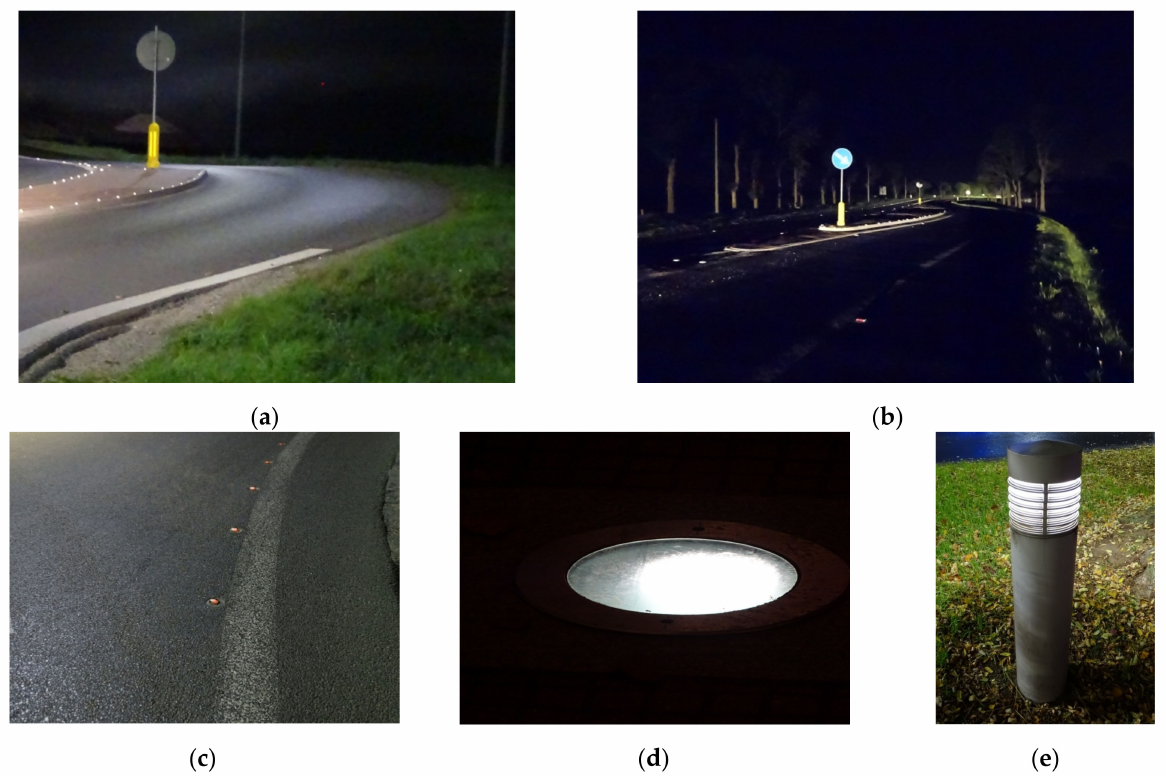
Figure 17. Example applications of auxiliary lighting elements: ( a ) conventional reflective PEO curb markers on the verge of the island; ( b ) conventional reflective elements placed on various elements of the chicane; ( c ) conventional surface mounted reflective road studs PEO; ( d ) SolarCAP Road LED lights mounted in the outer edge of the carriageway; ( e ) road edge marker posts including LED elements.